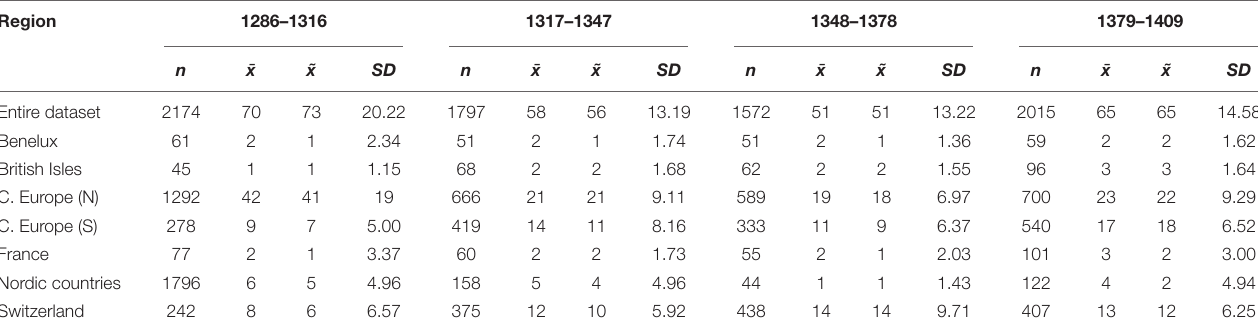
TABLE 4 | Summary statistics for the felling dates for the 31-year periods around the time of the Late Medieval Crisis including the number ( n ) mean ( ¯x ), median ( ˜x ), and standard deviation ( SD ).